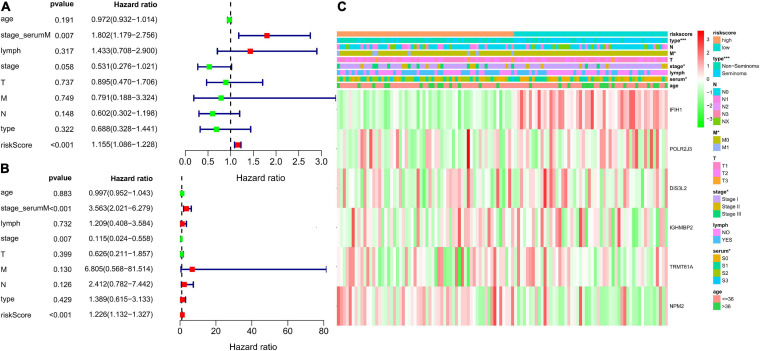
Analysis for evaluating the independent prognostic value of the risk score. Forrest plot of univariate (A) and multivariate (B) Cox regression analysis of risk score, age, serum markers, lymphovascular invasion, TNM stage, disease type, and stage. (C) Significant differences were found for the disease type, M stage, serum markers, and stage between high- and low-risk group. *p < 0.05, **p < 0.01, and ***p < 0.001 compared with the low-risk group.